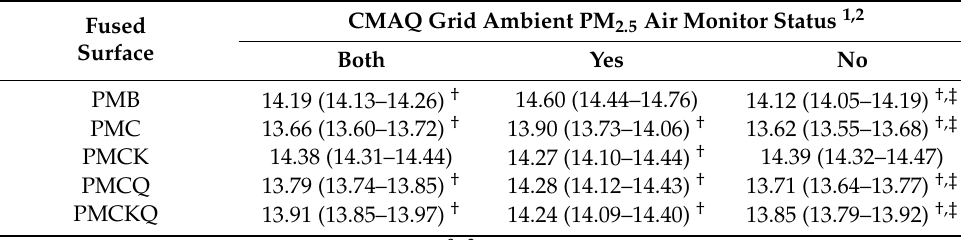
Table 5. Three-year mean concentration levels for the four AOD-PM 2.5 and baseline PMB fused surfaces by air monitor grid status in the Baltimore study